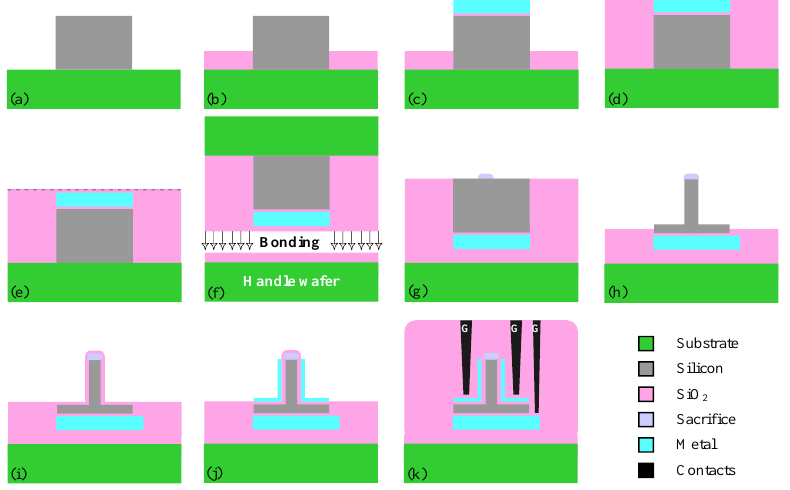
Figure 2. The manufacturing process flow of an inverted T-shape structure. ( a – c ) Fin process. ( d ) oxide deposition, ( e ) CMP, ( d ) Bonding, ( g – j ) selective etch and metal gate deposition, and ( k ) contacts connection.